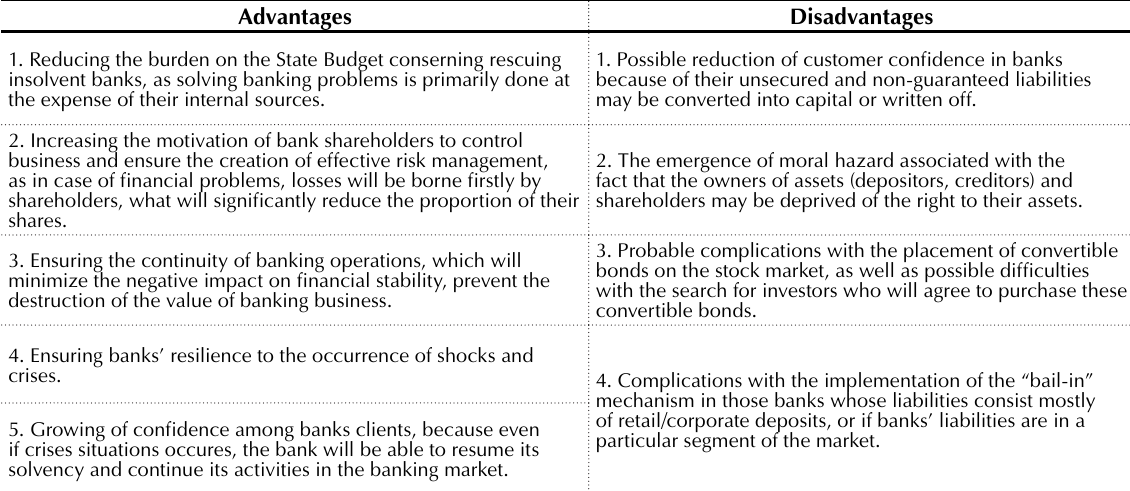
Table 1. Advantages and disadvantages of implementing the “bail-in” mechanism